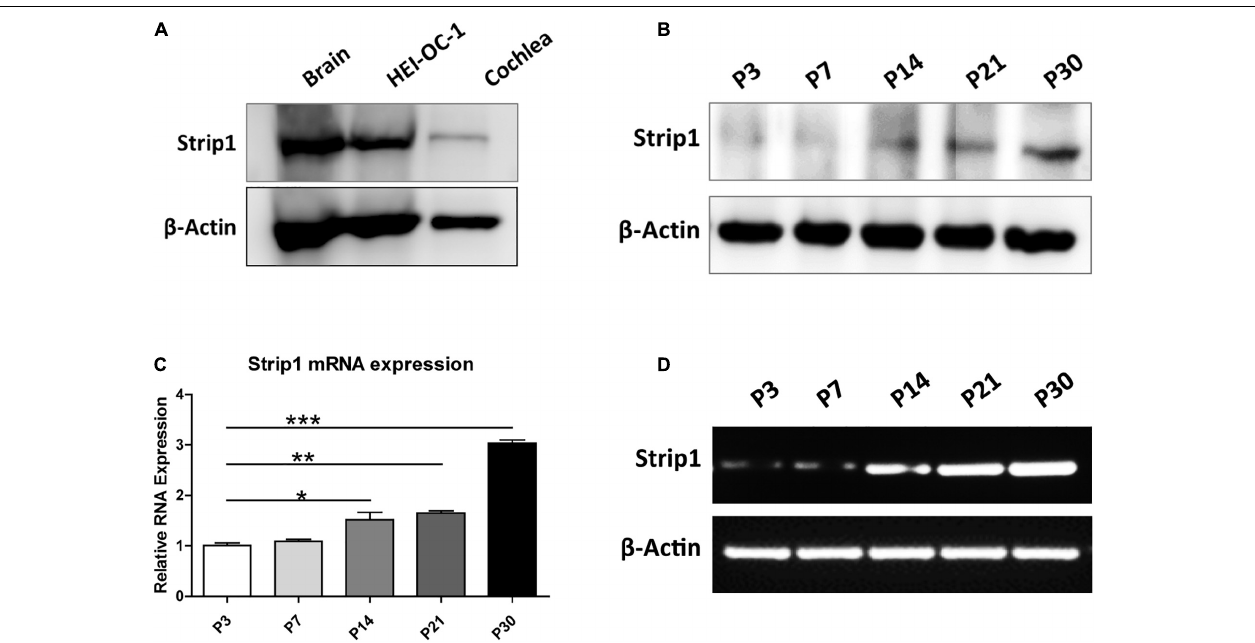
FIGURE 1 | Protein and mRNA expression of Strip1 in the mouse cochlea. (A,B) Western blotting showing the protein expression of Strip1 in the mouse brain, the HEI-OC1 HC cell line, and in the mouse cochlea at P3 (A) and in the mouse cochlea at different ages (B) . (C,D) mRNA expression of Strip1 in the mouse cochlea at different ages by qPCR (C) and RT-PCR (D) . β -actin was used as the endogenous reference gene. Four independent qPCR were performed in (C) . * p < 0.05, ** p < 0.01, *** p <